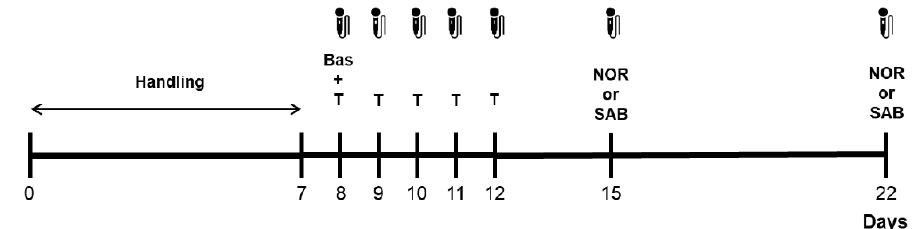
Figure 1. Experimental plan. A total of 40 rats were gently handled daily for 7 consecutive days. The day after, rats were evaluated a single time for their basal calling behavior and, starting the same day, subjected to tickling for 5 consecutive days. On days 15 and 22, rats were arranged in two groups of 20 subjects and tested once either in the novel object recognition test or in the single trial continuous spontaneous alternation behavior test in a Y maze. Testing was done in a counterbalanced manner and the emission of ultrasonic vocalizations was recorded throughout the experiments. Bas = recording of basal calling behavior before the beginning of tickling; NOR = novel object recognition test; SAB = spontaneous alternation behavior; T = tickling.